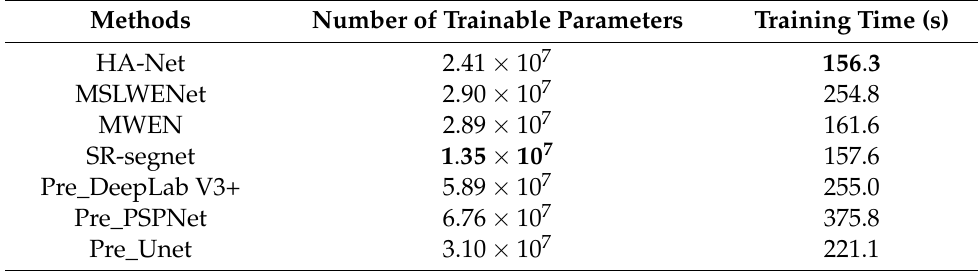
Table 2. The comparison results for model complexity and training